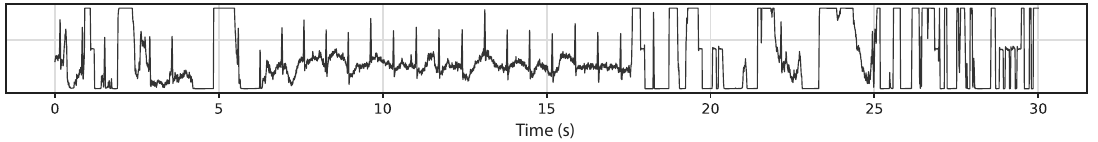
Figure 1. Example excerpt of the signal used, acquired on the steering wheel whilst driving. It is